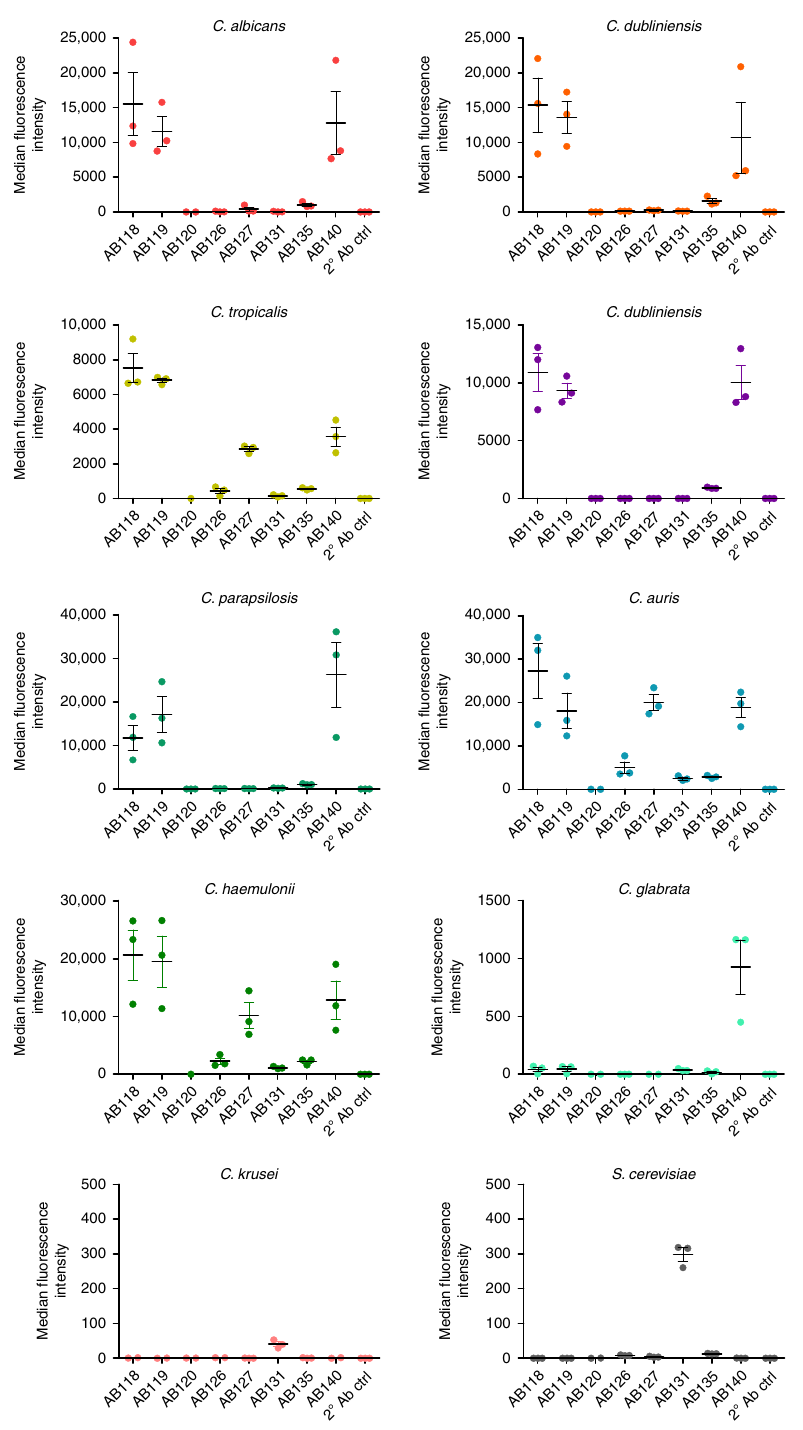
Fig. 5 Binding of anti- Candida mAbs to panel of Candida species and S . cerevisiae . Binding of anti-Hyr1 mAb and anti-whole cell mAbs (one mAb from each clonal cluster) to yeast cells of different Candida species and S . cerevisiae . Data were obtained using a BD Fortessa fl ow cytometer. Dots represent single experiments and horizontal lines represent the mean of median fl uorescence intensities ± SEM ( n = 3) weights (Supplementary Figure 8a). We also tested the ability of burdens and weight change at day 7 following Evotec ’ s standard antibody AB119 to protect prophylactically. This study was protocol. Prophylactic treatment with AB119 signi fi cantly conducted using a blinded protocol by Evotec (UK) Ltd. An reduced kidney fungal burdens compared to IgG1 control mAb irrelevant IgG1 isotype control mAb or AB119 was administered (Fig. 10b). Burden results were re fl ected in mouse body weights by intraperitoneal injection 4 h prior to challenge with C. albicans (Supplementary Figure 8b). Therefore, the anti-whole cell mAb SC5314 yeast cells via intravenous injection into the mouse lateral AB119 also demonstrated protection in a prophylactic mouse tail vein. Disease progression was measured by kidney fungal model of systemic Candida infection. NATURE COMMUNICATIONS| (2018) 9:5288